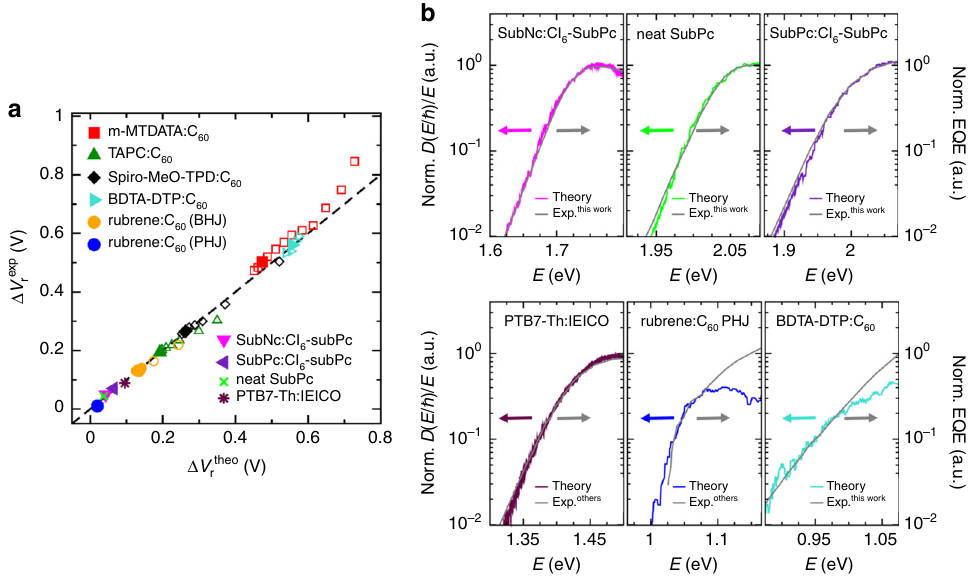
Fig. 5 Comparison of theoretical and experimental values for Δ V r and sub-gap tails. a Comparison of vibration-tail-induced voltage losses Δ V r from theory and experiment for all investigated donor – acceptor systems at room temperature ( fi lled symbols) and varying temperatures (open symbols). For rubrene:C 60 , we distinguish bulk heterojunction (BHJ) and planar heterojunction (PHJ) geometries. The dashed line indicates equality between simulated and experimental radiative voltage losses. b Simulated spectra and experimental EQE for devices with non-fullerene acceptors and additionally investigated materials. The EQE data for PTB7-Th:IEICO and rubrene:C 60 are taken from the literature 21, 50 ,